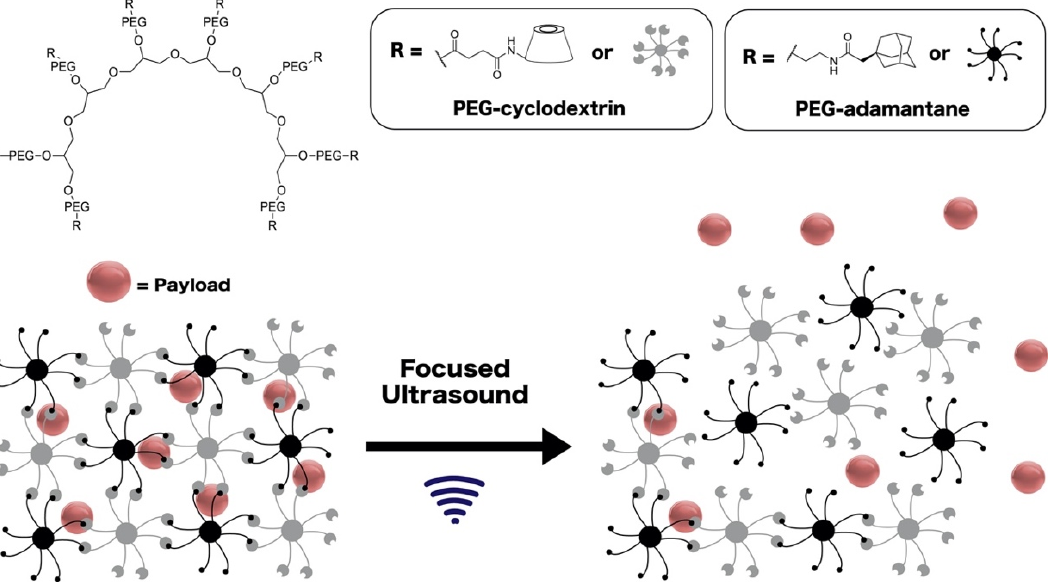
Figure 4. Design of ultrasound-responsive supramolecular PEG hydrogels crosslinked with a host- guest interaction between PEG- β -cyclodextrin and PEG-adamantane. This hydrogel matrix was developed by Yamaguchi et al. [100] and used for the controlled delivery of protein payloads. Table 1. Characteristics of ultrasound-responsive hydrogels for tissue engineering